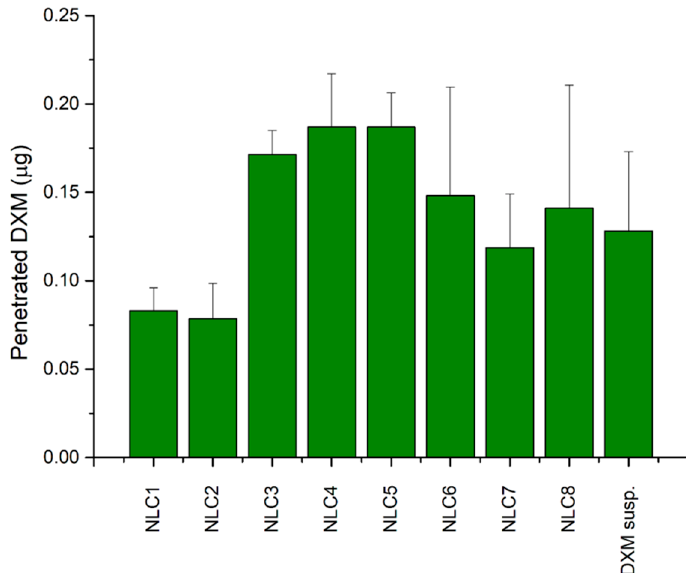
Figure 7. Comparison of the diffused amounts of DXM through the Corneal-PAMPA model.